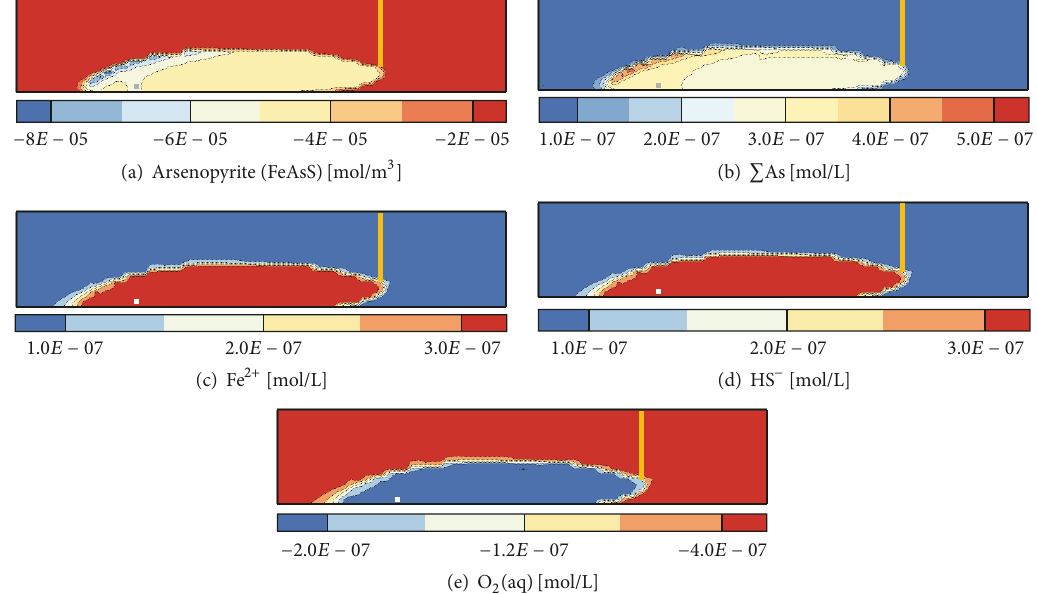
Figure 8: Distribution of arsenopyrite dissolution and associated dissolved species ( ∑ As, Fe 2+ , HS − , and O 2 (aq)) after 365